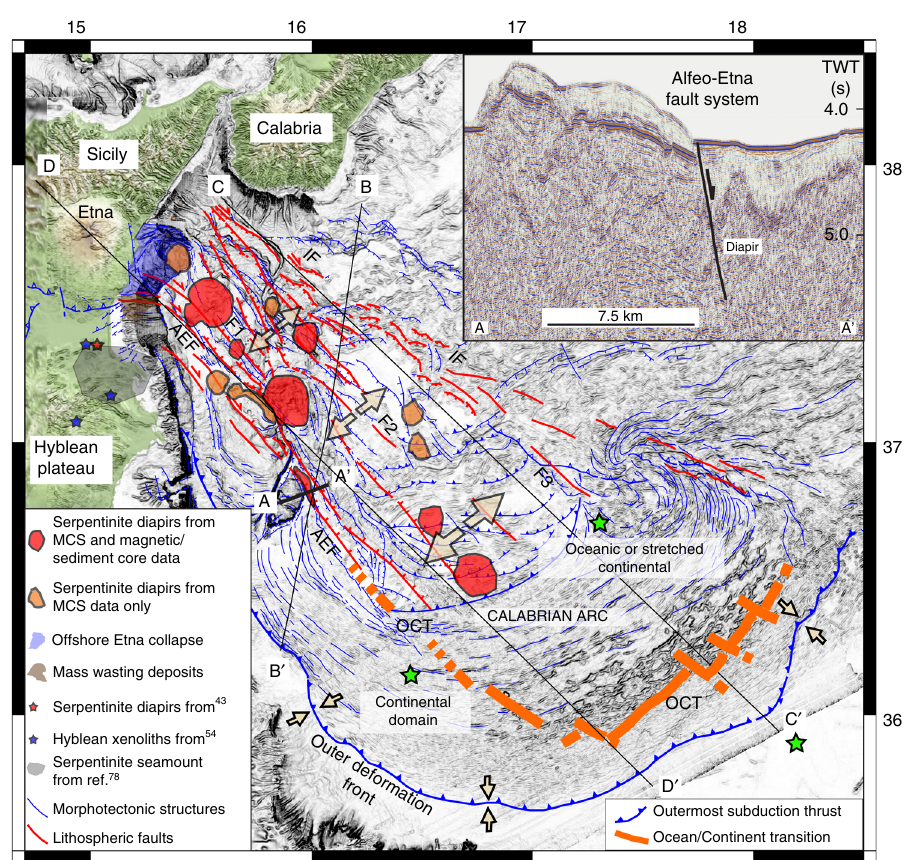
Fig. 5 Structural map of the Western Calabrian Arc subduction complex with distribution of tectonically controlled serpentinite diapirs. Faulting associated with arc-perpendicular extensional tectonics in the accretionary wedge (modi fi ed from ref. 17 ) provides an opportunity for fl uids to be introduced deep into the underplating plate. A-A ’ : MCS line CALA-02 across a diapir in the sedimentary basin formed along the Alfeo-Etna fault. A diapiric intrusion of serpentinite bearing clayey material in the Hyblean plateau suggests af fi nity of clays with hydrothermally modi fi ed ma fi c and ultrama fi c rocks forming the Hyblean lower crust 43,78 . Sections B-B ’ and C-C ’ are shown in Fig. 6, section D-D ’ in Fig. 8. Green stars: OBS/H stations used for P- and S-wave velocity model for the Ionian lithosphere 26 . AEF, Alfeo-Etna fault; IF, Ionian fault; OCT, Oceanic-Continent transition. F1, F2, F3, transtensional faults belonging to the AEF-IF deformation zone